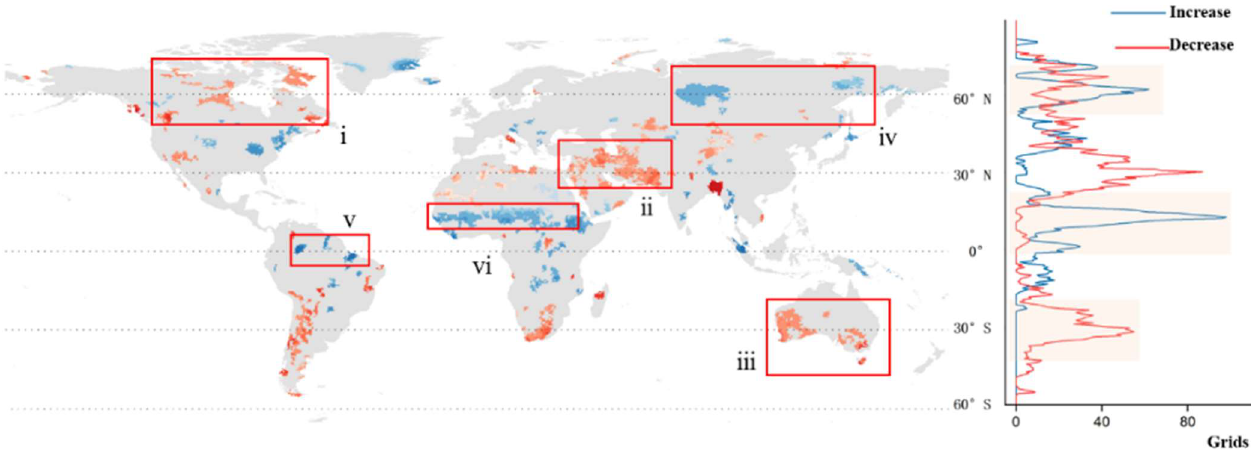
Figure 12. Statistics for the confirmed trends of terrestrial water yield (WY) represented as the number of grid cells by the latitude. Blue and red indicate a significant increase and decrease in WY during 1981–2018 after correcting for multiple hypothesis testing (α = 0.05), respectively. The red boxes indicate the areas of interest, including parts of Canada ( ⅰ ), Siberia ( ⅱ ), West Asia ( ⅲ ), Australia ( ⅳ ), Central Africa ( ⅴ ), and the Amazon ( ⅵ ).